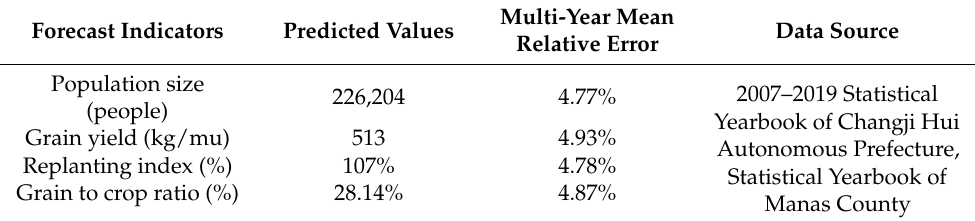
Table 3. Prediction index of cultivated land possession.